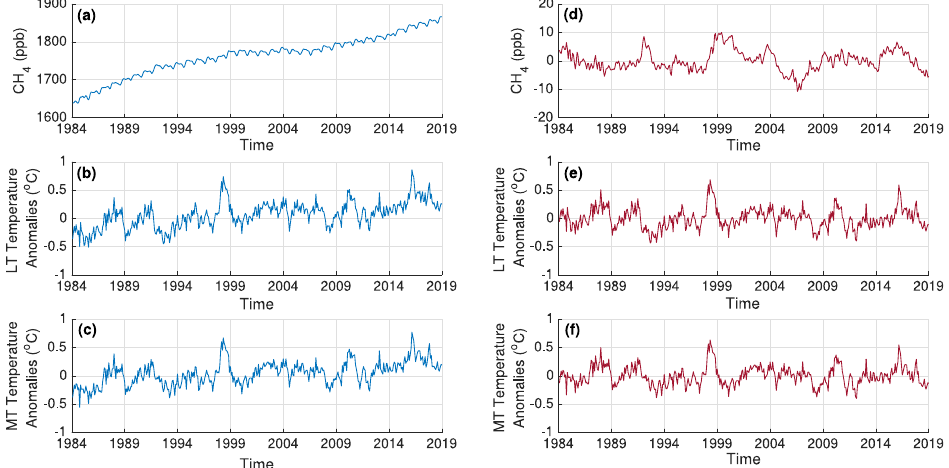
Figure 1. Time series of initial ( a – c ) and processed ( d – f ) global CH 4 and temperature anomalies of the lower troposphere (LT) and mid-troposphere (MT).